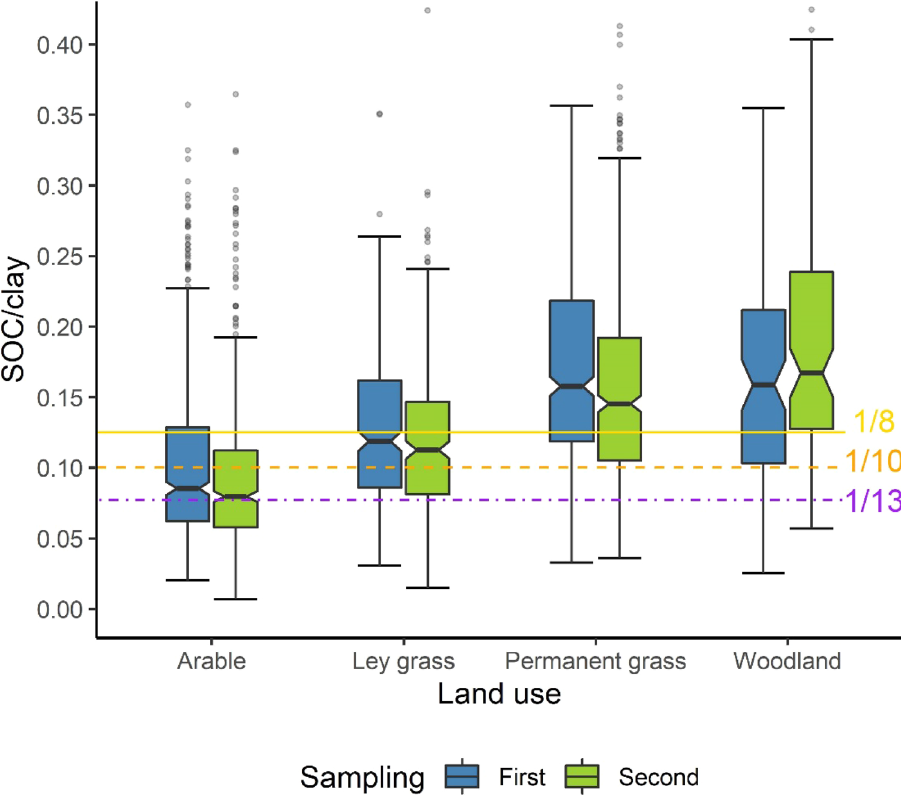
Figure 2. Boxplots of SOC/clay for each land use and sampling of the NSI. Notches extend to 1.58 × interquartile range/square-root(n) either side of the median and indicate 95% confidence around the median. Whiskers extend to the furthest point within 1.5 × interquartile range below the 25th-, or above the 75th percentiles. Observations outside of the whisker ranges are represented as points. The y-axis was truncated to 0.41 meaning that 11 points (across the data) are not